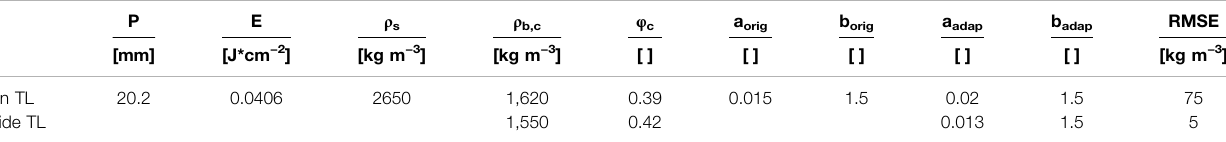
TABLE 1 | Original and adapted parameters for Eq. 1 : amount of rainfall P, cumulative rainfall energy E, density of solid particles ρ s , fi nal bulk density ρ b,c , fi nal porosity φ c , original and adapted parameters a and b and root-mean-square-error RMSE of the fi nal measured and modelled bulk density; TL: Tractor lane. P